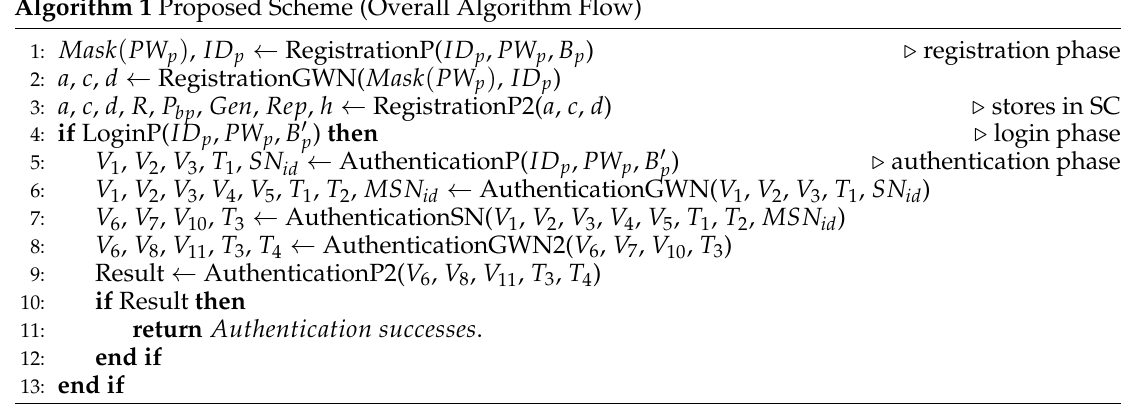
Algorithm 1 Proposed Scheme (Overall Algorithm